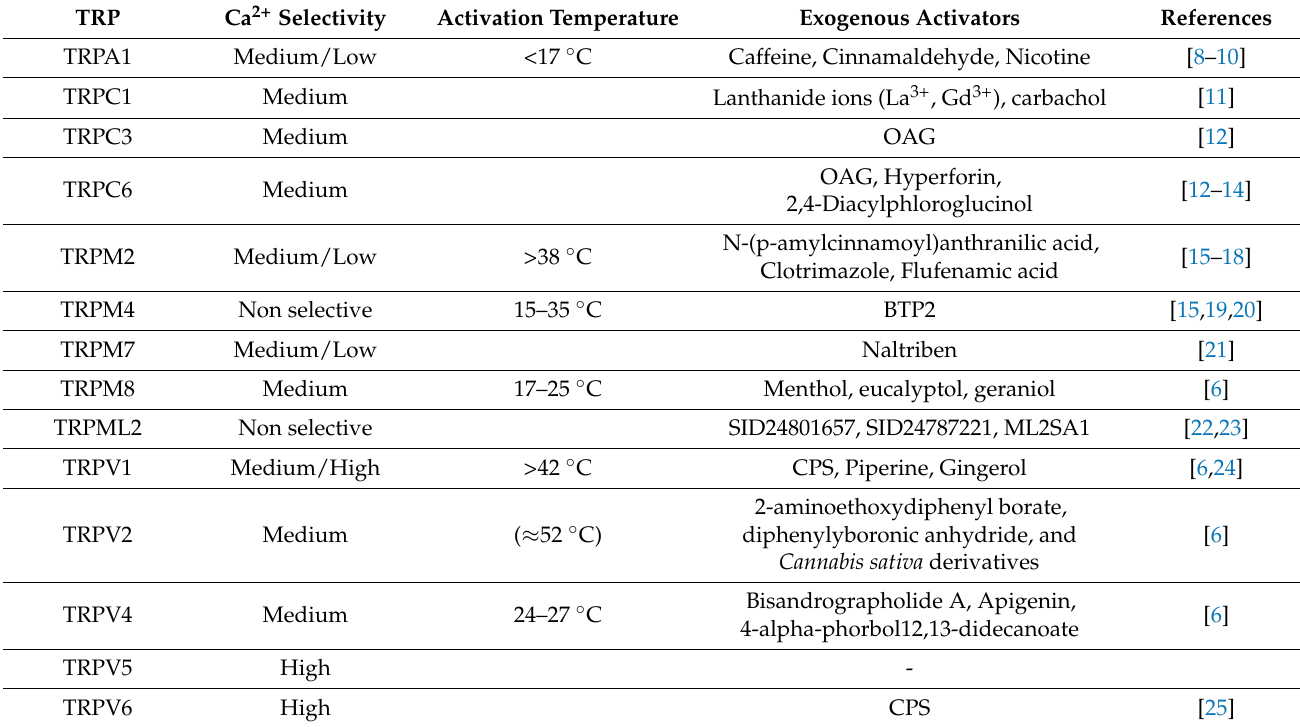
Table 1. Environmental activating stimuli and calcium permeability characteristics of TRP